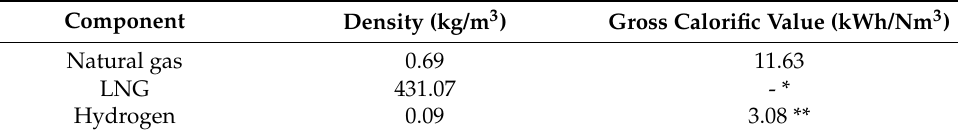
Table 4. Natural gas, LNG and hydrogen